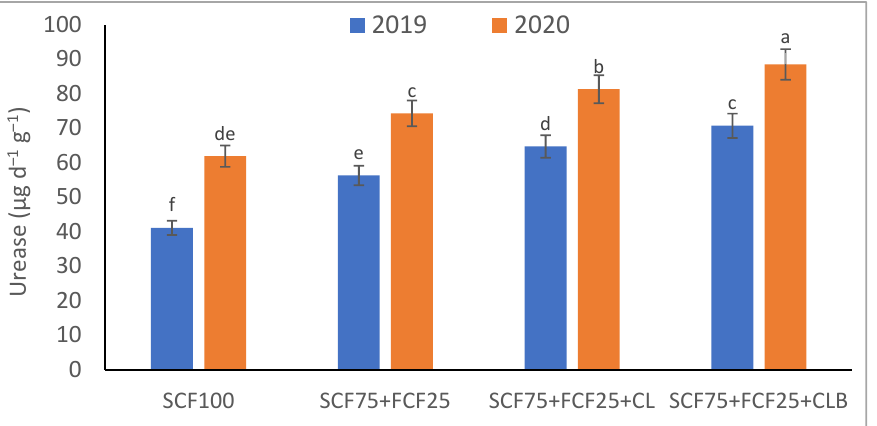
Figure 5. Response of soil enzyme activities (urease) to different fertilization strategies applied in